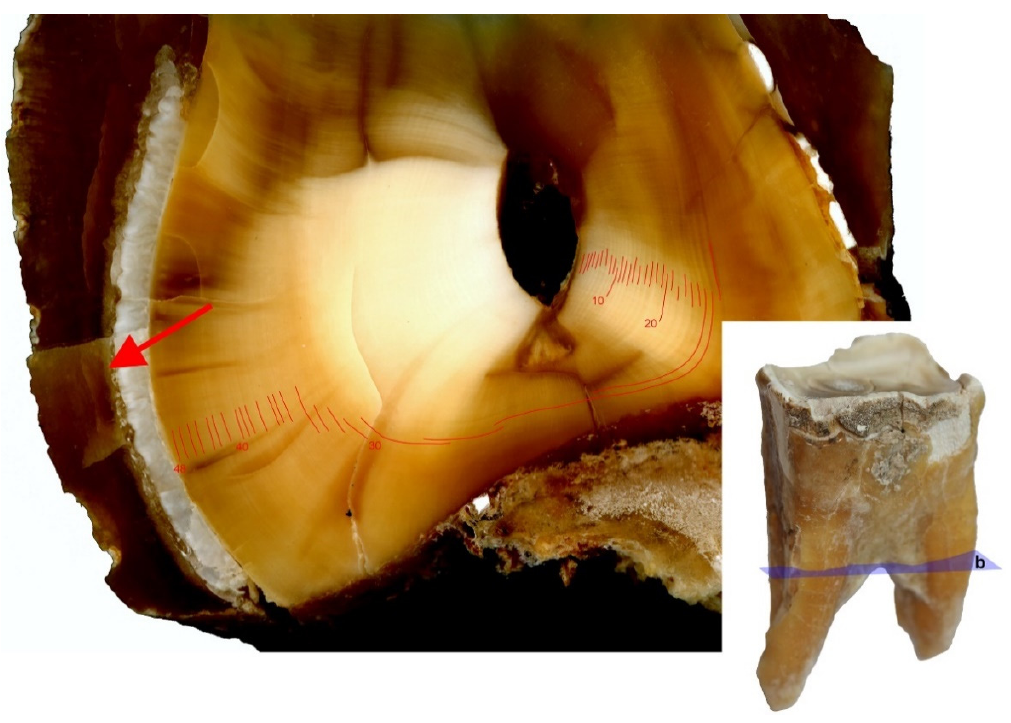
Figure 8. Dentine growth lines on horizontal (axial, transverse) sections of the upper part of the caudal root, on the third premolar (P 3 ) of the white rhinoceros female, b : horizontal (axial, transverse) sections through the upper part of the root. The cement area analyzed in Figure 6a,b indicated with red arrow.